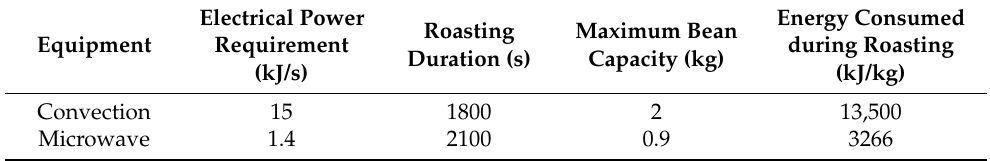
Table 3. Comparison of electrical energy consumption between the Selmi roaster (convection: 130 °C–30 min) and the Samsung domestic microwave oven (microwave: 600 W–35 min), taking into account the applied roasting conditions used in this study.